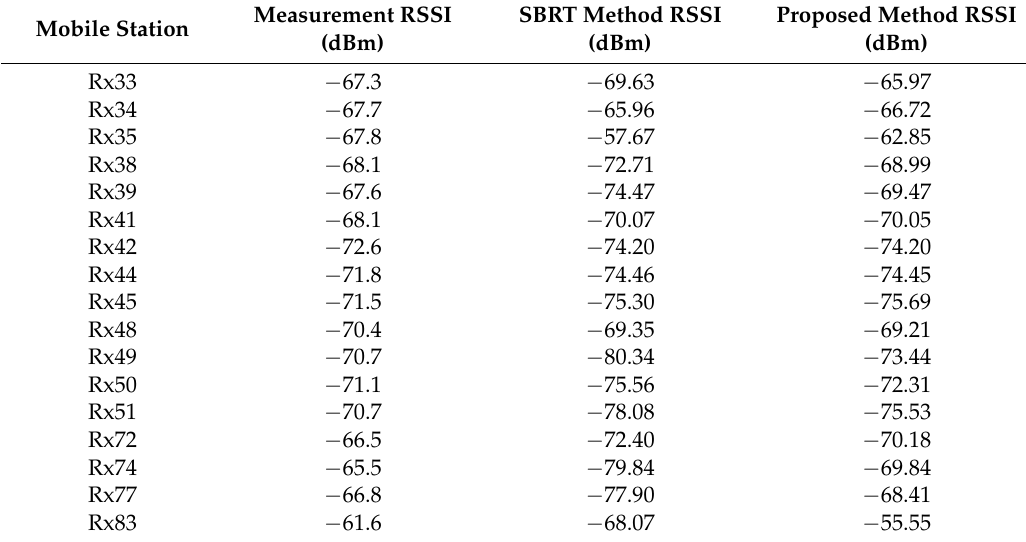
Table 4. Comparison of received signal strength indication (RSSI) data among measurement, SBRT method, and proposed method.